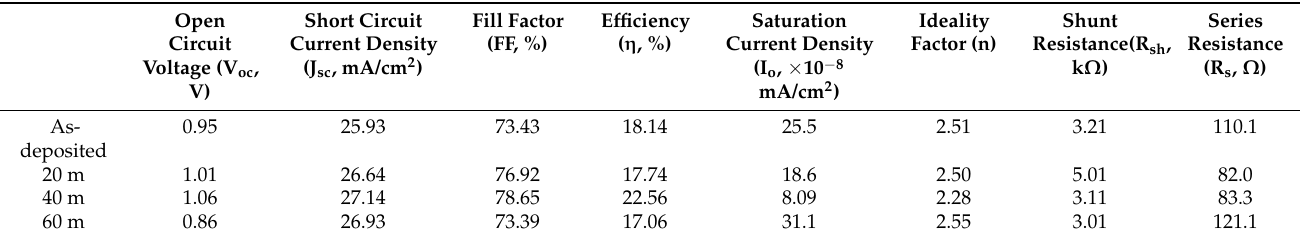
Table 2. The performance parameter, including electrical properties of the perovskite solar cells, using Cu x O thin films as a hole transport material